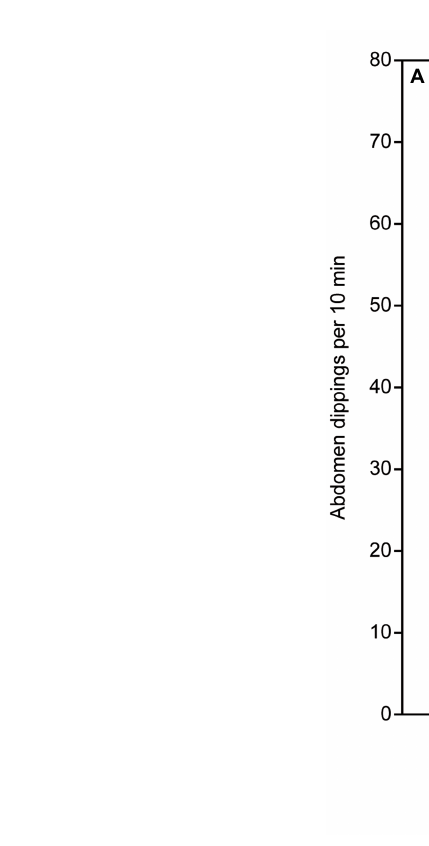
FIGURE 7 The presence of a parasitized host does not influence male marking behavior. (A) Frequency of abdomen dipping shown by mated males within a 10-min observation time in the absence or presence of a host containing females about to emerge. ( Β ) Location of abdomen dipping by mated males when a host was present. Box and whisker plots show median (horizontal line), 25%–75% quartiles (box), maximum/minimum range [whiskers; n = 25, data analysis by a (A) Mann–Whitney U -test and (B) Wilcoxon matched-pairs